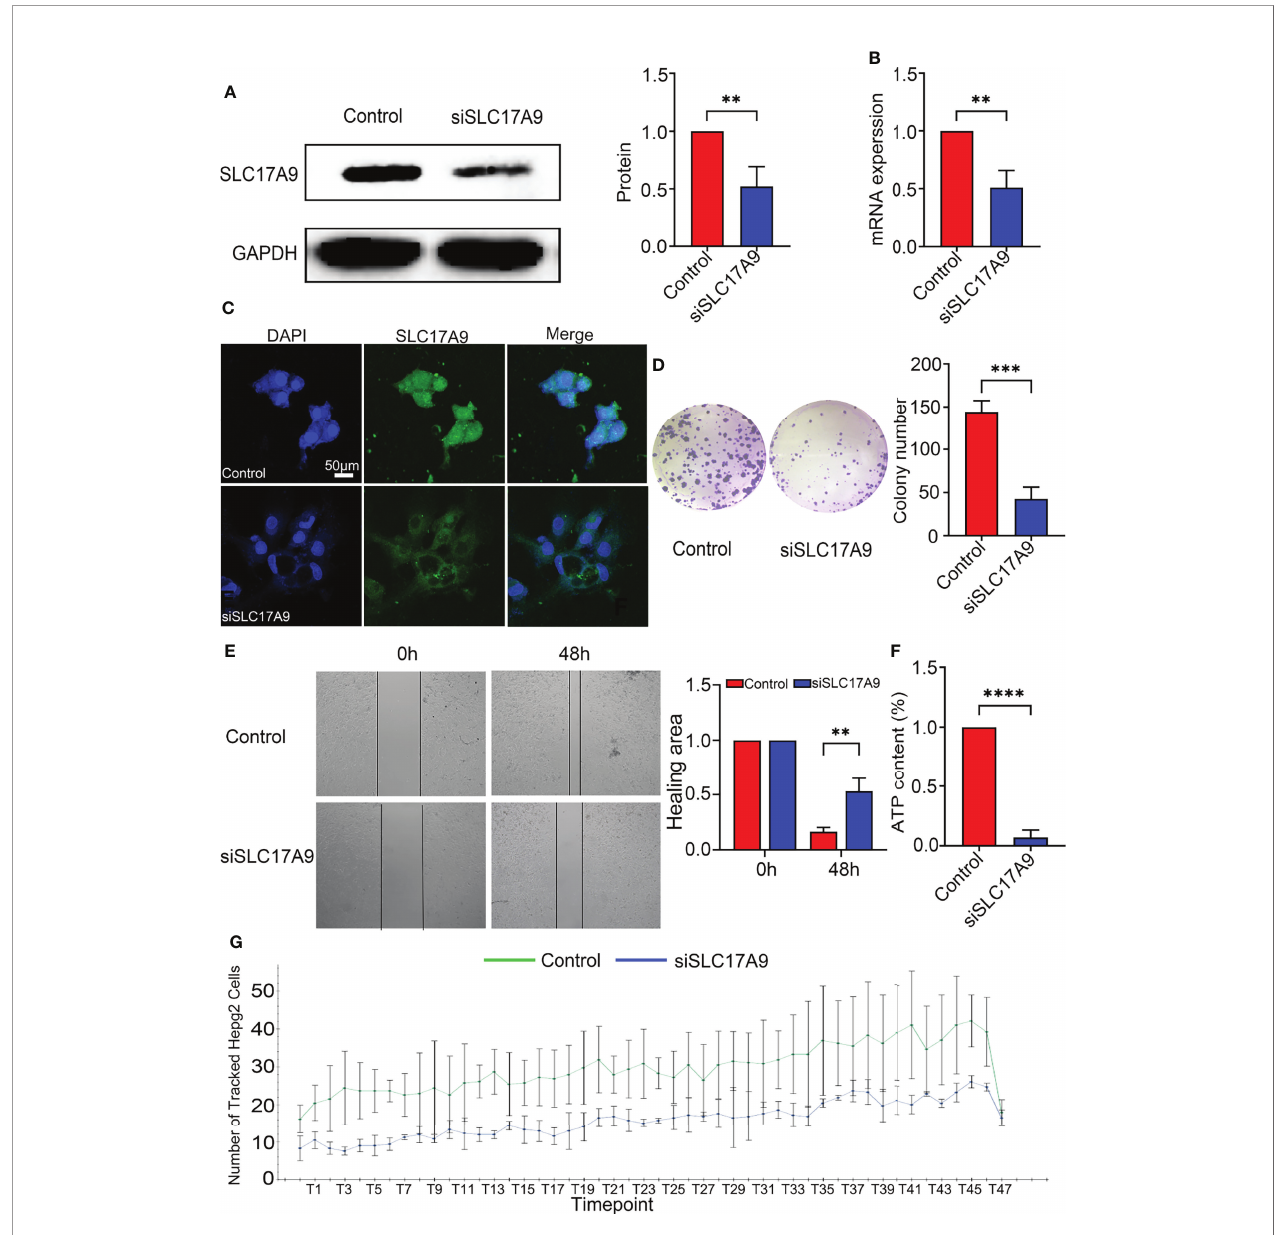
FIGURE 4 | Silencing of SLC17A9 reduced malignant phenotypes of liver cancer. (A) Western blot showed the knockdown ef fi cacy of SLC17A9 siRNA. (B) SLC17A9 mRNA expression level in control and siSLC17A9 groups. (C) Immuno fl uorescence detection of proliferation rate. (D) Colony formation assay results in control and siSLC17A9 groups. (E) Wound healing assay after transfection with SLC17A9 siRNA or control siRNA. (F) ATP levels were measured in the control and siSLC17A9 groups. (G) Using high-content imaging to detect the increment rate of cells in different periods. *p < 0.05; **p < 0.01; ***p < 0.001; ****p